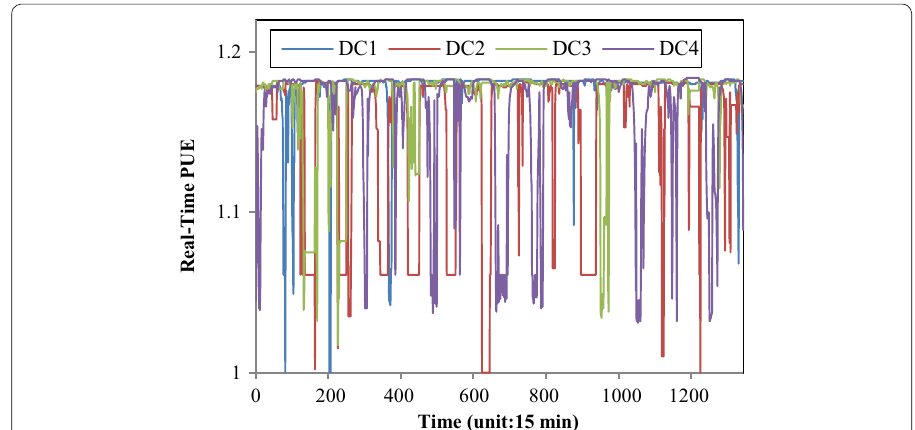
Fig. 6 Variation of Real-Time PUE over the time